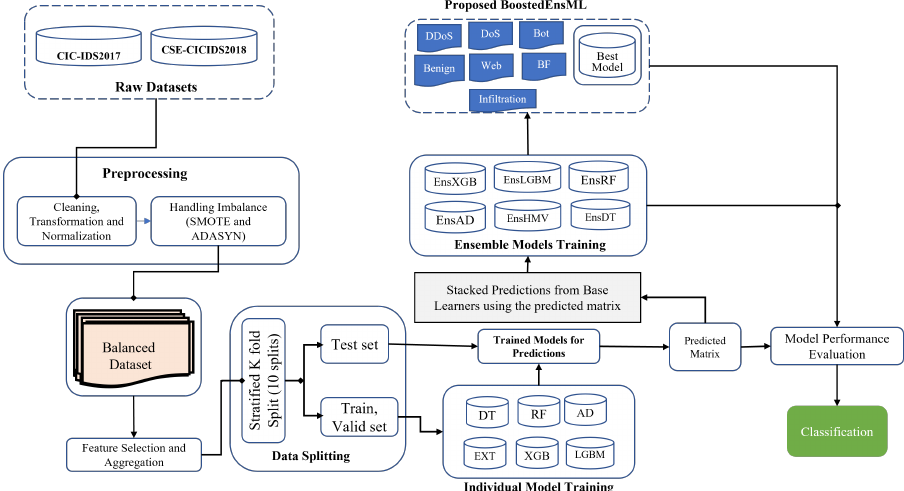
Figure 1. Design architecture of BoostedEnML for IDS in IoT